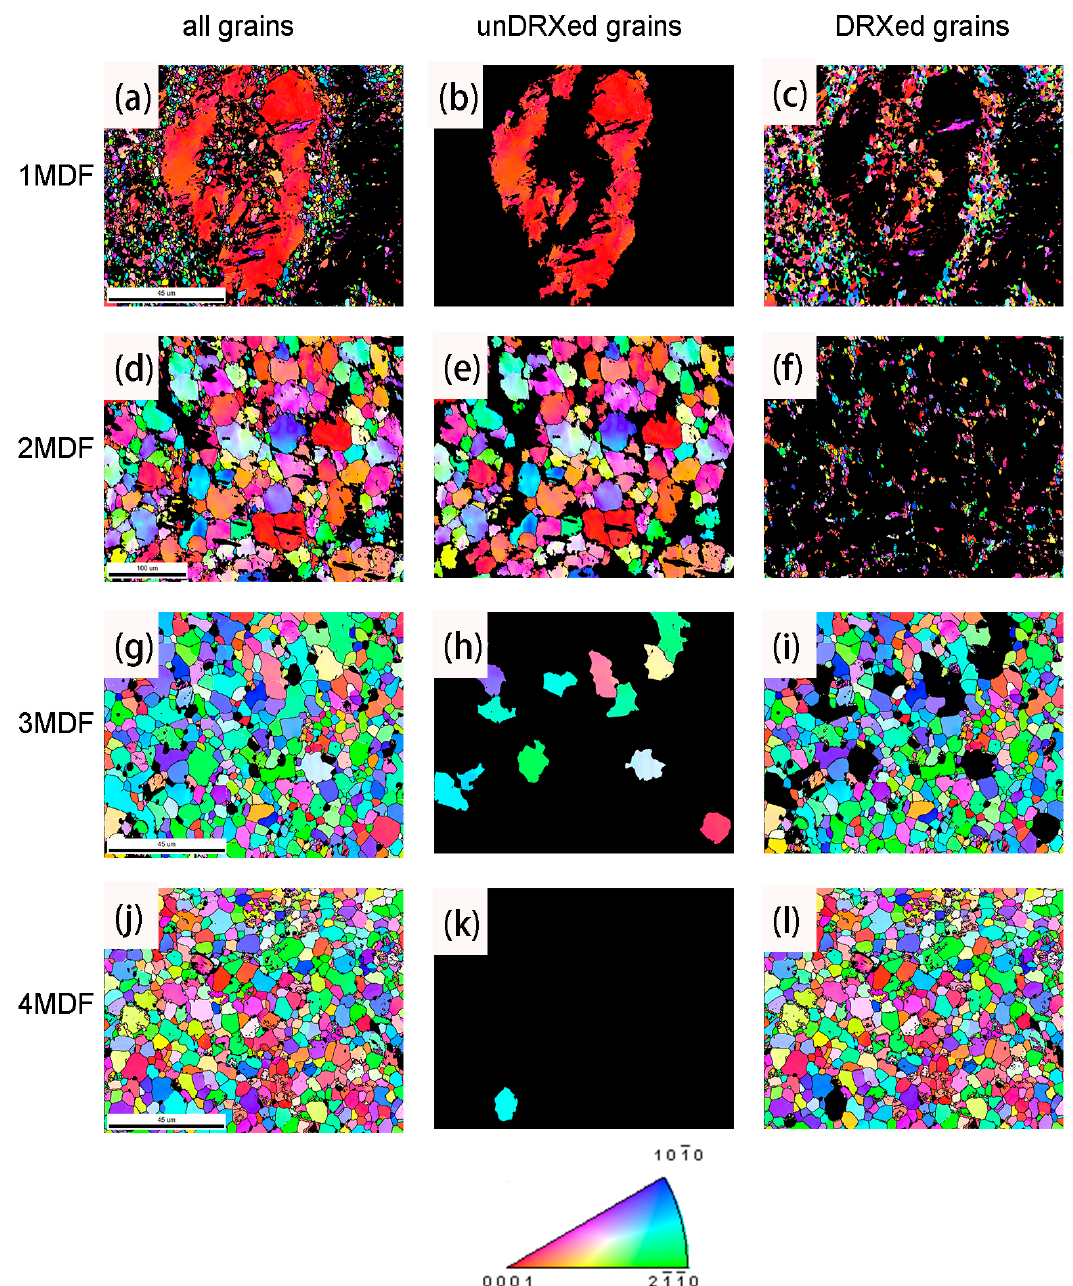
Figure 10. Inverse pole figure (IPF) maps for the experimental alloy after MDF to di ff erent passes, ( a , d , g , j ) the IPF images of all grains after di ff erent passes, ( b , e , h , k ) the IPF images of unDRXed grains after di ff erent passes, ( c , f , i , l ) the IPF images of DRXed grains after di ff erent passes, and the orientation triangle is also showed.